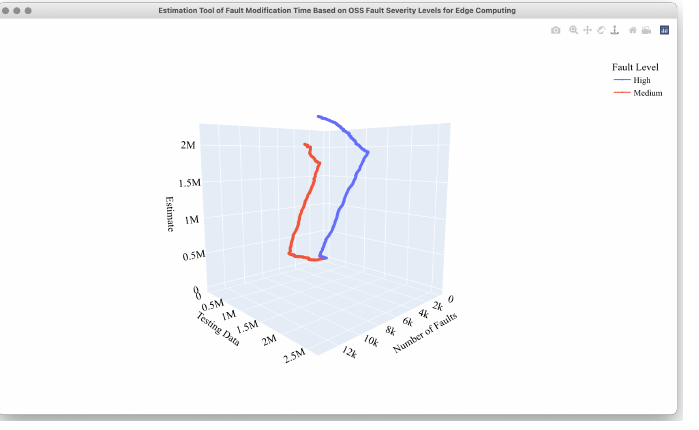
Figure 17. The overall picture of the estimated cumulative fault correction time in case of 30% testing